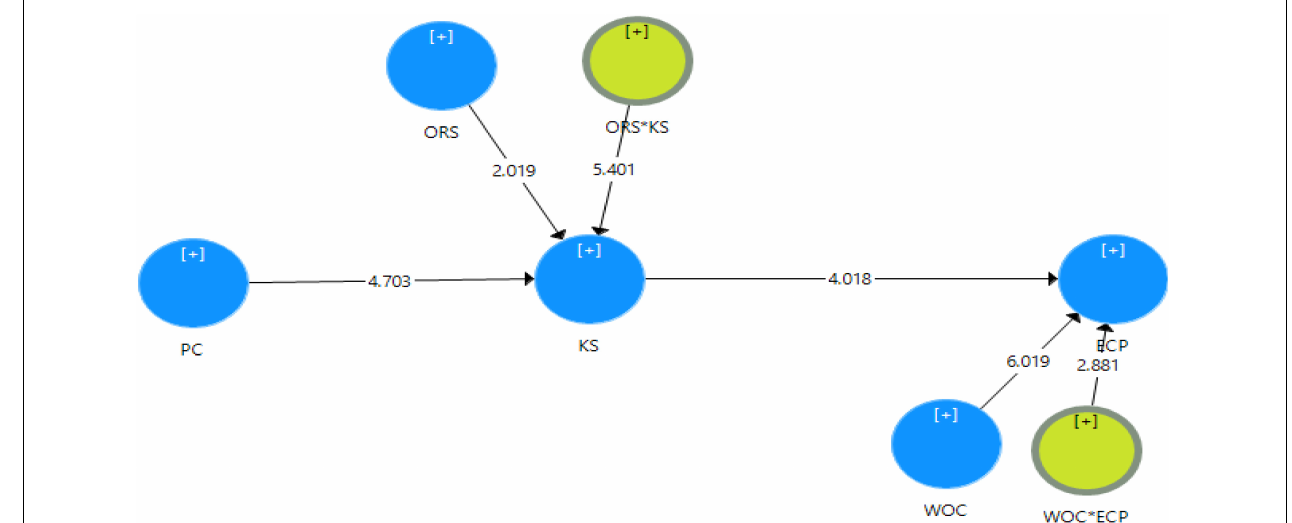
FIGURE 2 | PLS-SEM model with indirect and direct effects.